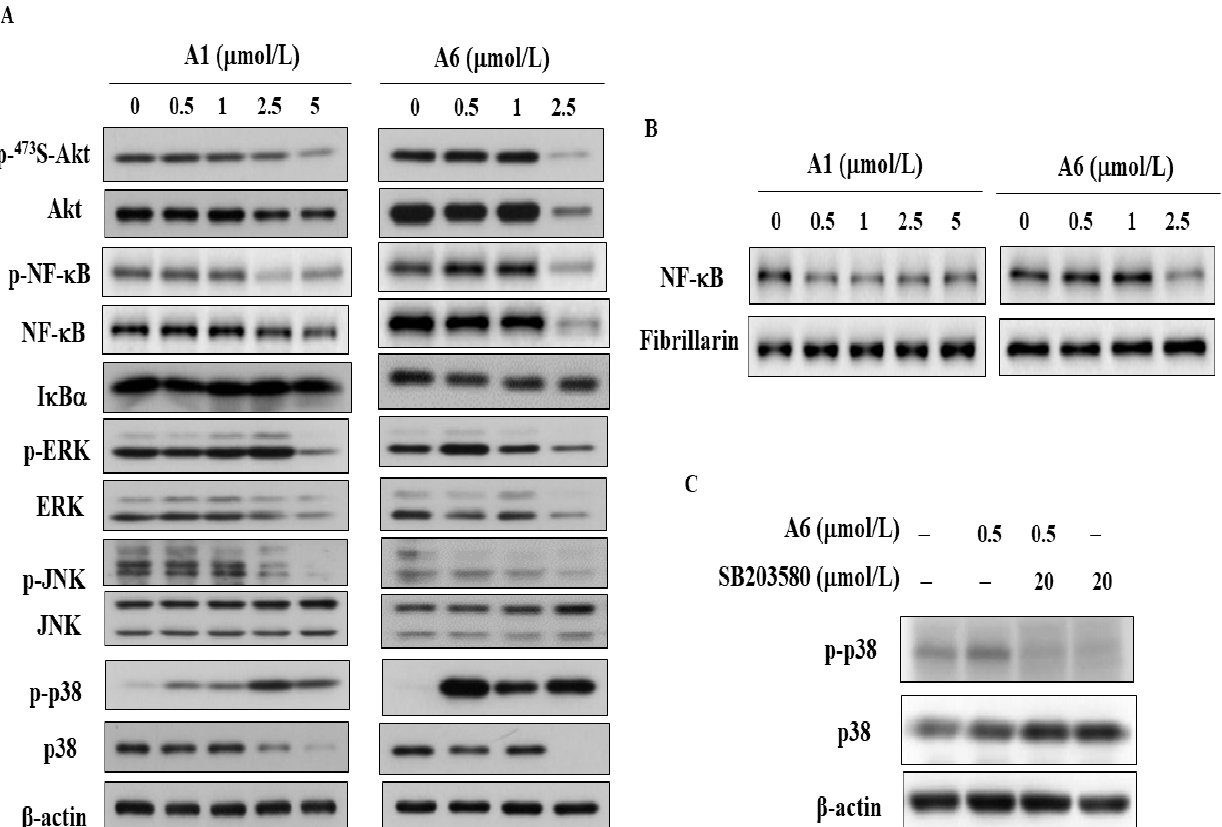
Figure 5. Effects of A1 and A6 on Akt/NF- κ B and MAPKs in Hep3B cells. ( A ) Phosphorylation/expression of Akt, NF- κ B, I κ B α , ERK, JNK, and p38 after treatment of Hep3B cells with A1 or A6. ( B ) Western blot analysis of the nuclear expression of NF- κ B. Proteins from nuclear cellular fractions were isolated from Hep3B cells treated with A1 or A6 for 48 h. Fibrillarin was used as a nucleus-specific loading control. ( C ) Phosphorylation and expression of p38 in cells treated with A6 (0.5 µ mol/L) alone or pre-treated with SB203580 (20 µ mol/L) for 15 min in Hep3B cells.